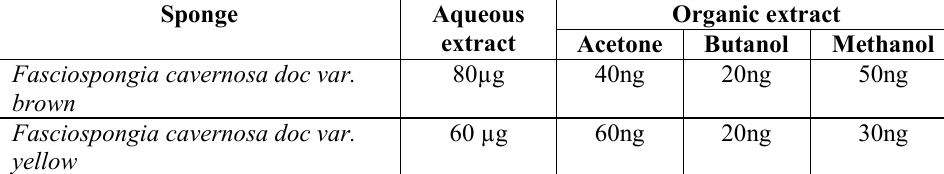
Table 3. Minimal Inhibitory Concentrations per mL of aqueous and organic Extracts.